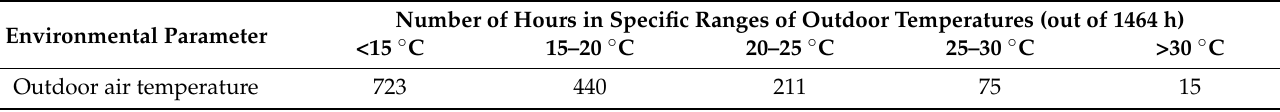
Table 1. The number of hours of outdoor air temperature in the given temperature ranges for the entire two-month analysis period. Number of Hours in Specific Ranges of Outdoor Temperatures (out of 1464 h) Environmental Parameter <15 ◦ C Outdoor air